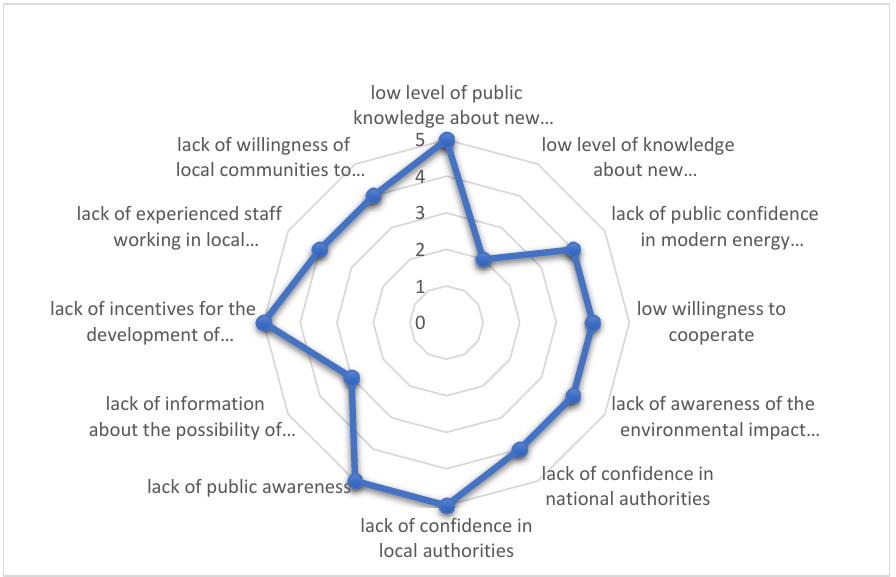
Figure 4. Relevance of challenges in energy development in rural areas as assessed by entrepreneurs. Source: own elaboration.